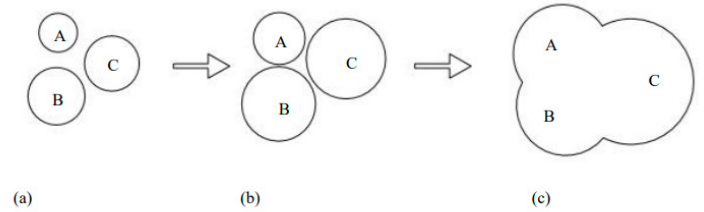
Figure 11. Development mode of rust pits A, B and C on the surface of steel bars. ( a ) Various sites of rust pits on the reinforcement surface; ( b ) rust pits developed toward the surrounding areas; ( c ) a large shallow pit and large rust pit.